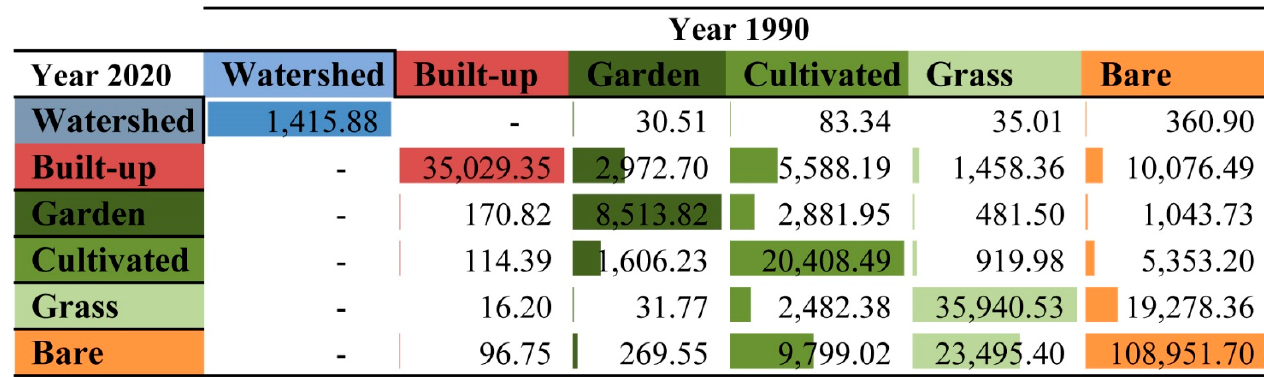
Figure 5. Percentage of land use classes in 1990 and 2020.